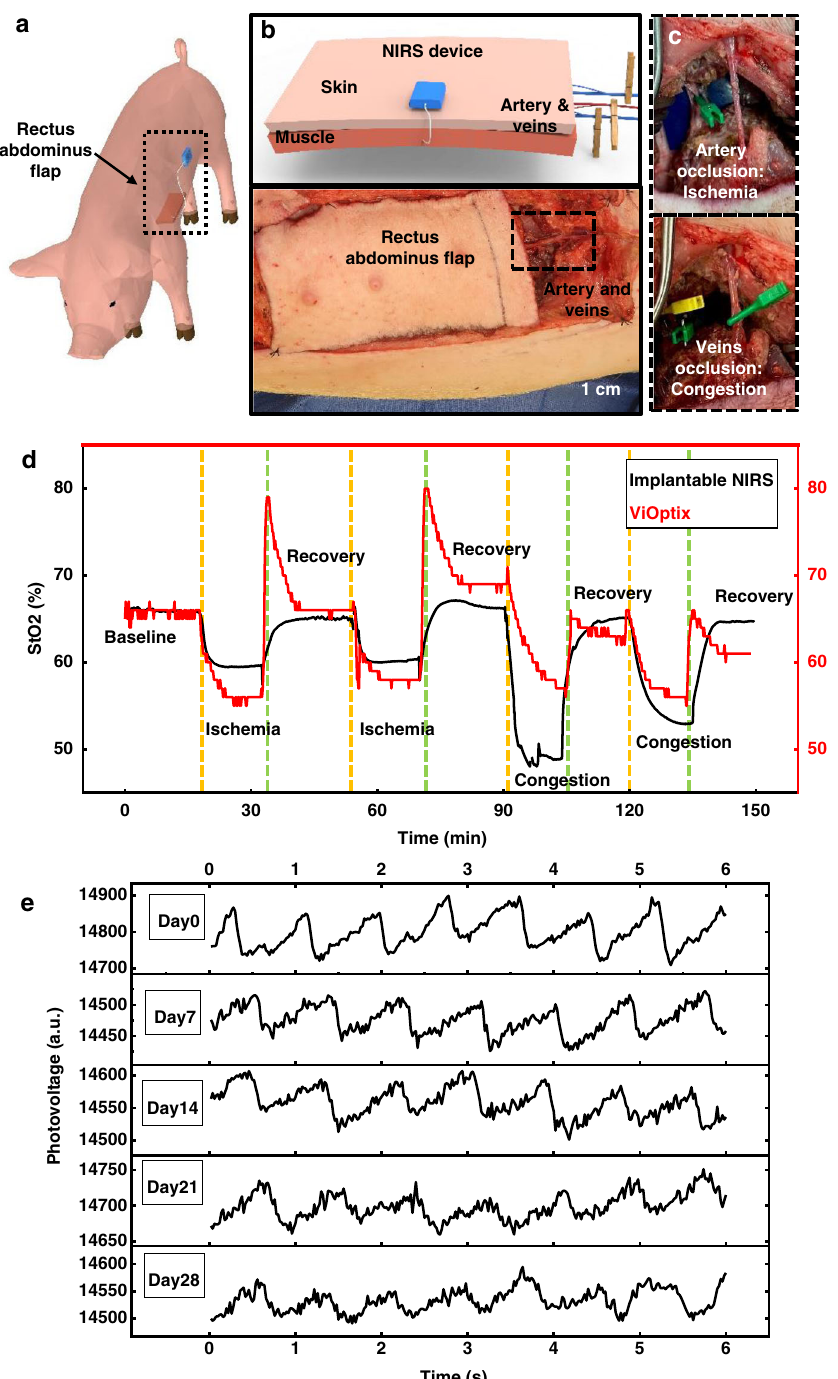
Fig. 4 In vivo measurements in a porcine fl ap model. a , b Schematic illustrations of the implantation strategy using the left rectus abdominus fl ap in a porcine model. c Image of the occlusion of arteries and veins to simulate events of ischemia and congestion, respectively. d Measured tissue oxygenation saturation from the implantable NIRS probe and from a skin-mounted device (ViOptix) during multiple experimental cycles that simulate events of ischemia and congestion. e Measured patterns of pulsation recorded from the fi ngertips using a NIRS probe after immersion in phosphate buffered saline solution at 37 °C for various time periods. Source data are provided as a Source Data fi Figure 4a – c shows a schematic illustration and pictures of the left rectus abdominus myocutaneous fl ap, including the artery and veins that control all blood exchange to the fl ap. Figure S13 presents pictures of a right rectus abdominus myocutaneous fl ap that highlights changes in color with different conditions at various phases of the experiment: baseline, ischemia, and